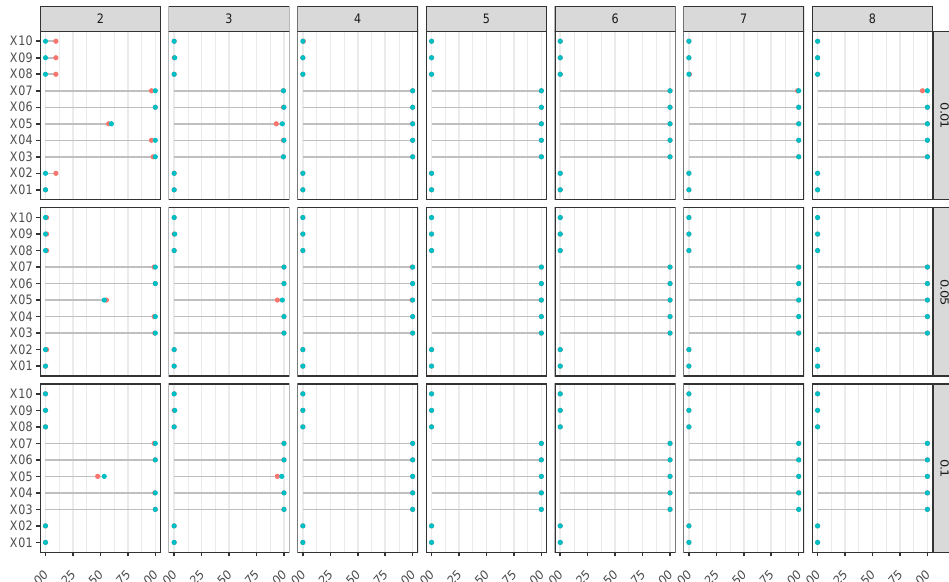
Figure 9. Model M3 (Friedman). Proportion of rejections of null hypothesis based on k -FWE test with k = 1, for 10 input variables, different combinations of hidden layer sizes ( m ∈ { 2,3, . . . ,8 } ), and weight-decay values ( λ ∈ { 0.01,0.05,0.1 } ). Nominal FWE was fixed at α = 0.10, 500 Monte Carlo runs, B = 999 bootstrap replicates, and n = 300 (in red) and n = 1000 (in blue). Table 1. Model M1 (Tibishirani), Test statistic T n , k -FWE rejection step (Step Rej), lower limits